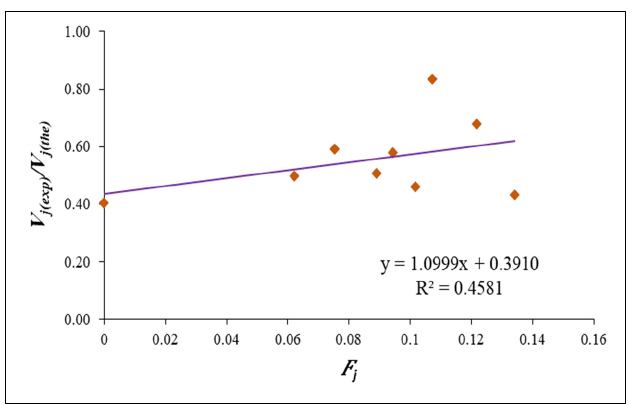
Figure 11. Correction factor ( F j ) against 𝑉 (cid:3037)((cid:2915)(cid:2934)(cid:2926)(cid:4667) /𝑉 (cid:3037)((cid:2930)(cid:2918)(cid:2915)(cid:4667)